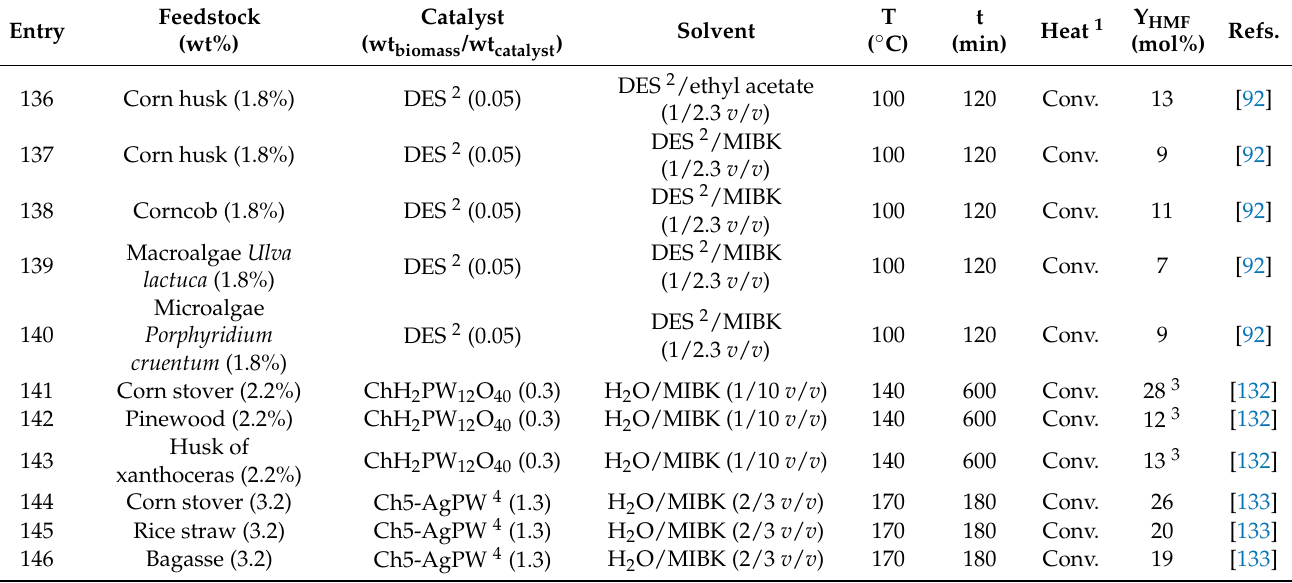
Table 6. HMF production from raw biomasses in biphasic and/or multiple-solvent systems with other